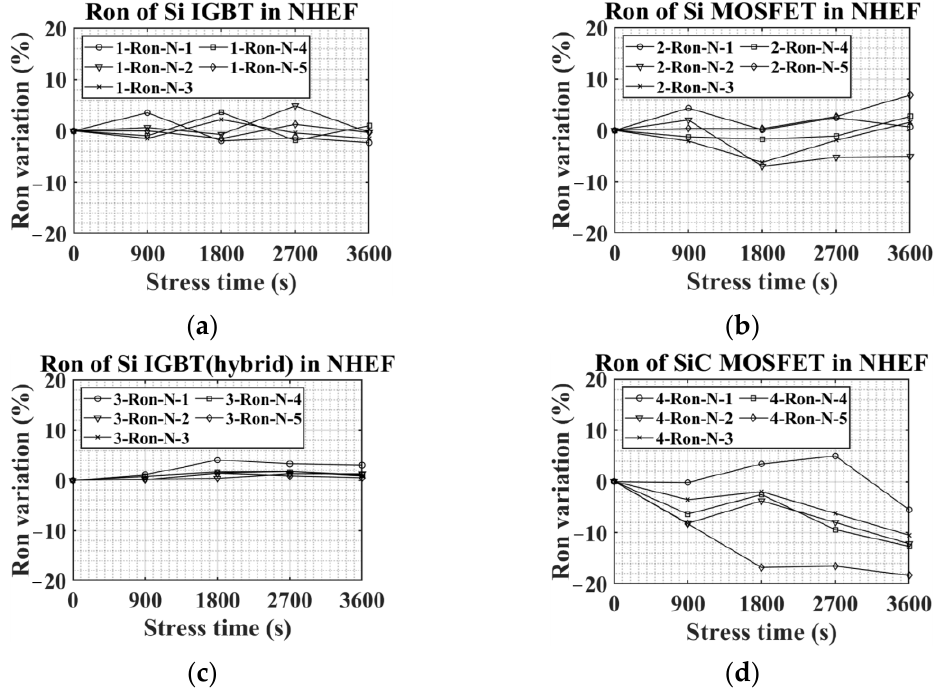
Figure 10. R on variations in NHEF stress: ( a ) Si IGBT, ( b ) Si MOSFET, ( c ) Si IGBT with SiC diode, and ( d ) SiC